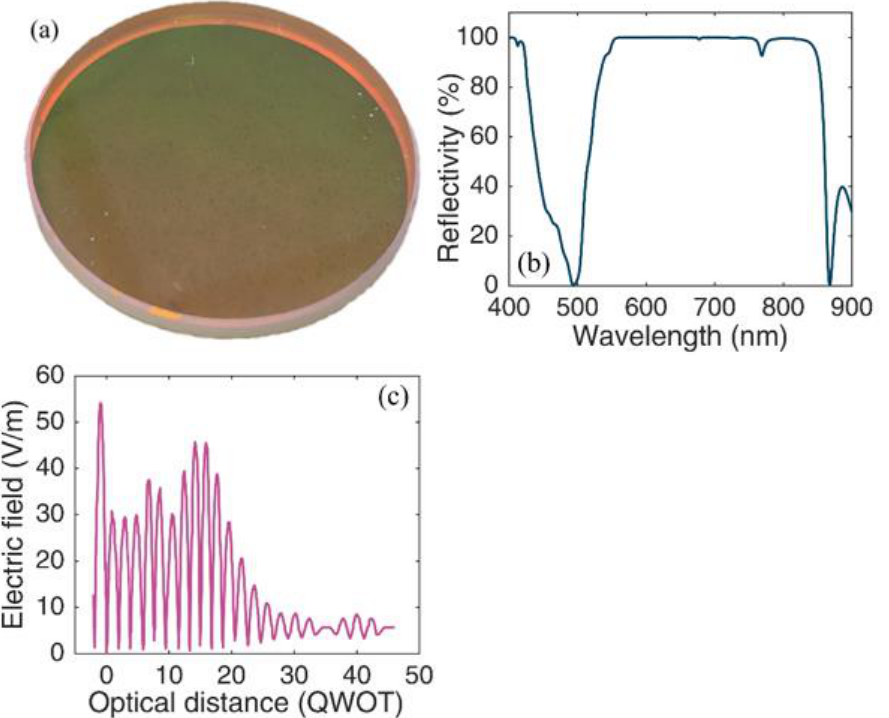
Figure 1. ( a ) Ta 2 O 5 /SiO 2 multilayer film sample; ( b ) reflectivity curve of the film; ( c ) electric field distribution of the film at 800